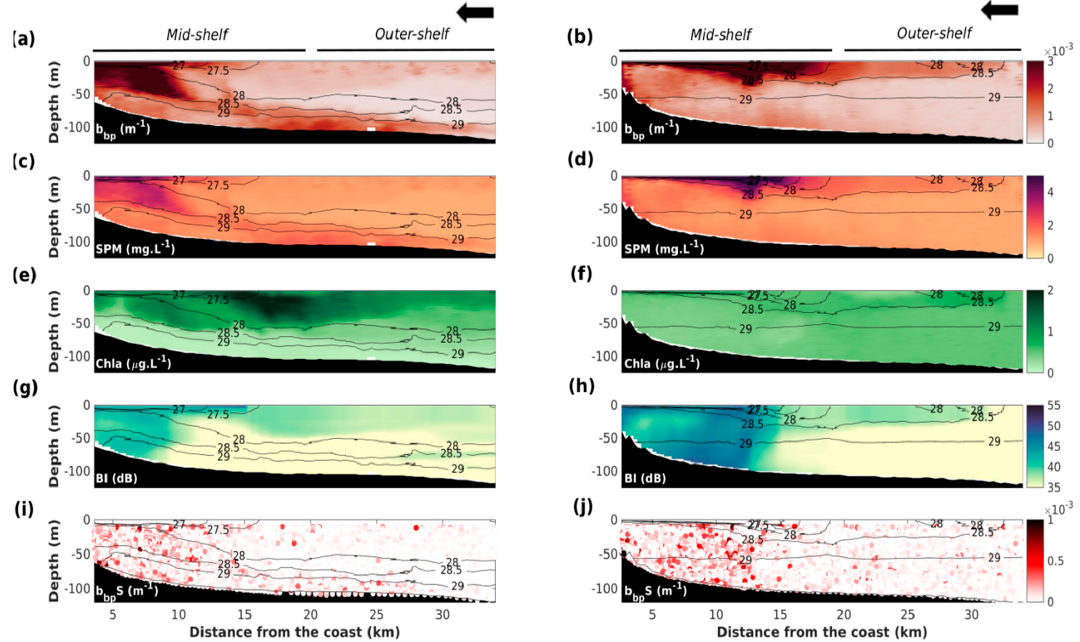
Figure 9. Turbidity measurements: ( a , b ) optical backscattering, ( c , d ) suspended particulate matter, ( e , f ) chlorophyll-a, ( g , h ) acoustic backscatter index, and ( i , j ) optical backscatter spikes. The left panels correspond to the autumnal season, from November 11 to 13, 2016. The right panels correspond to the winter season, from February 5 to 7, 2017. The black arrow at the top of each panel indicates the direction of the glider’s motion.